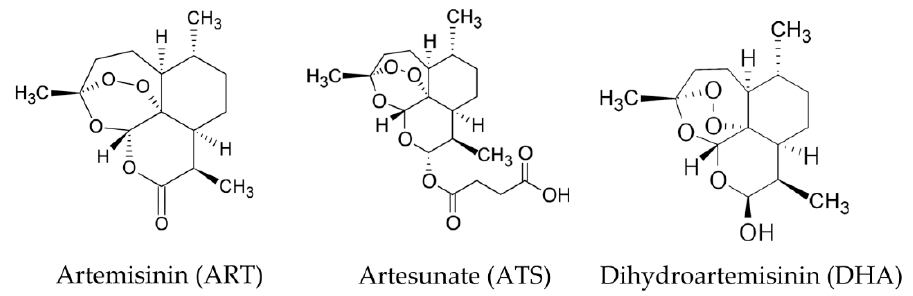
Figure 1. Chemical structure of artemisinin (ART), artesunate (ATS), and dihydroartemisinin (DHA).